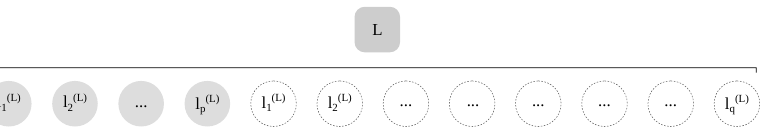
Figure 10. Prediction/application for a given initial value based on learning patterns l (see Section